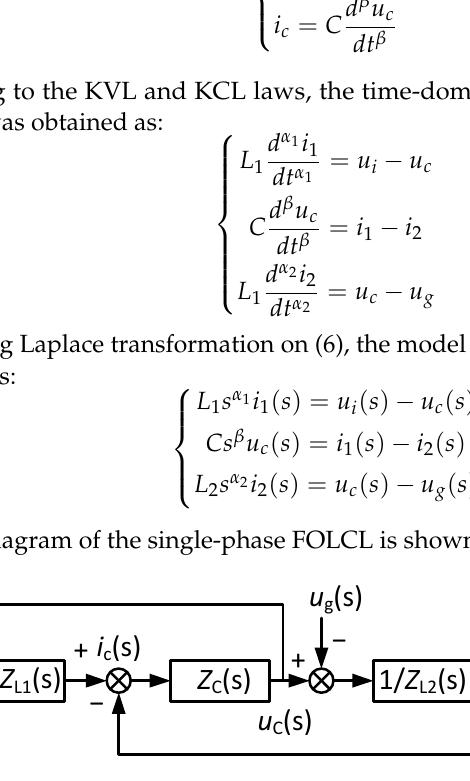
Figure 2. Block diagram of single-phase FOLCL filter.